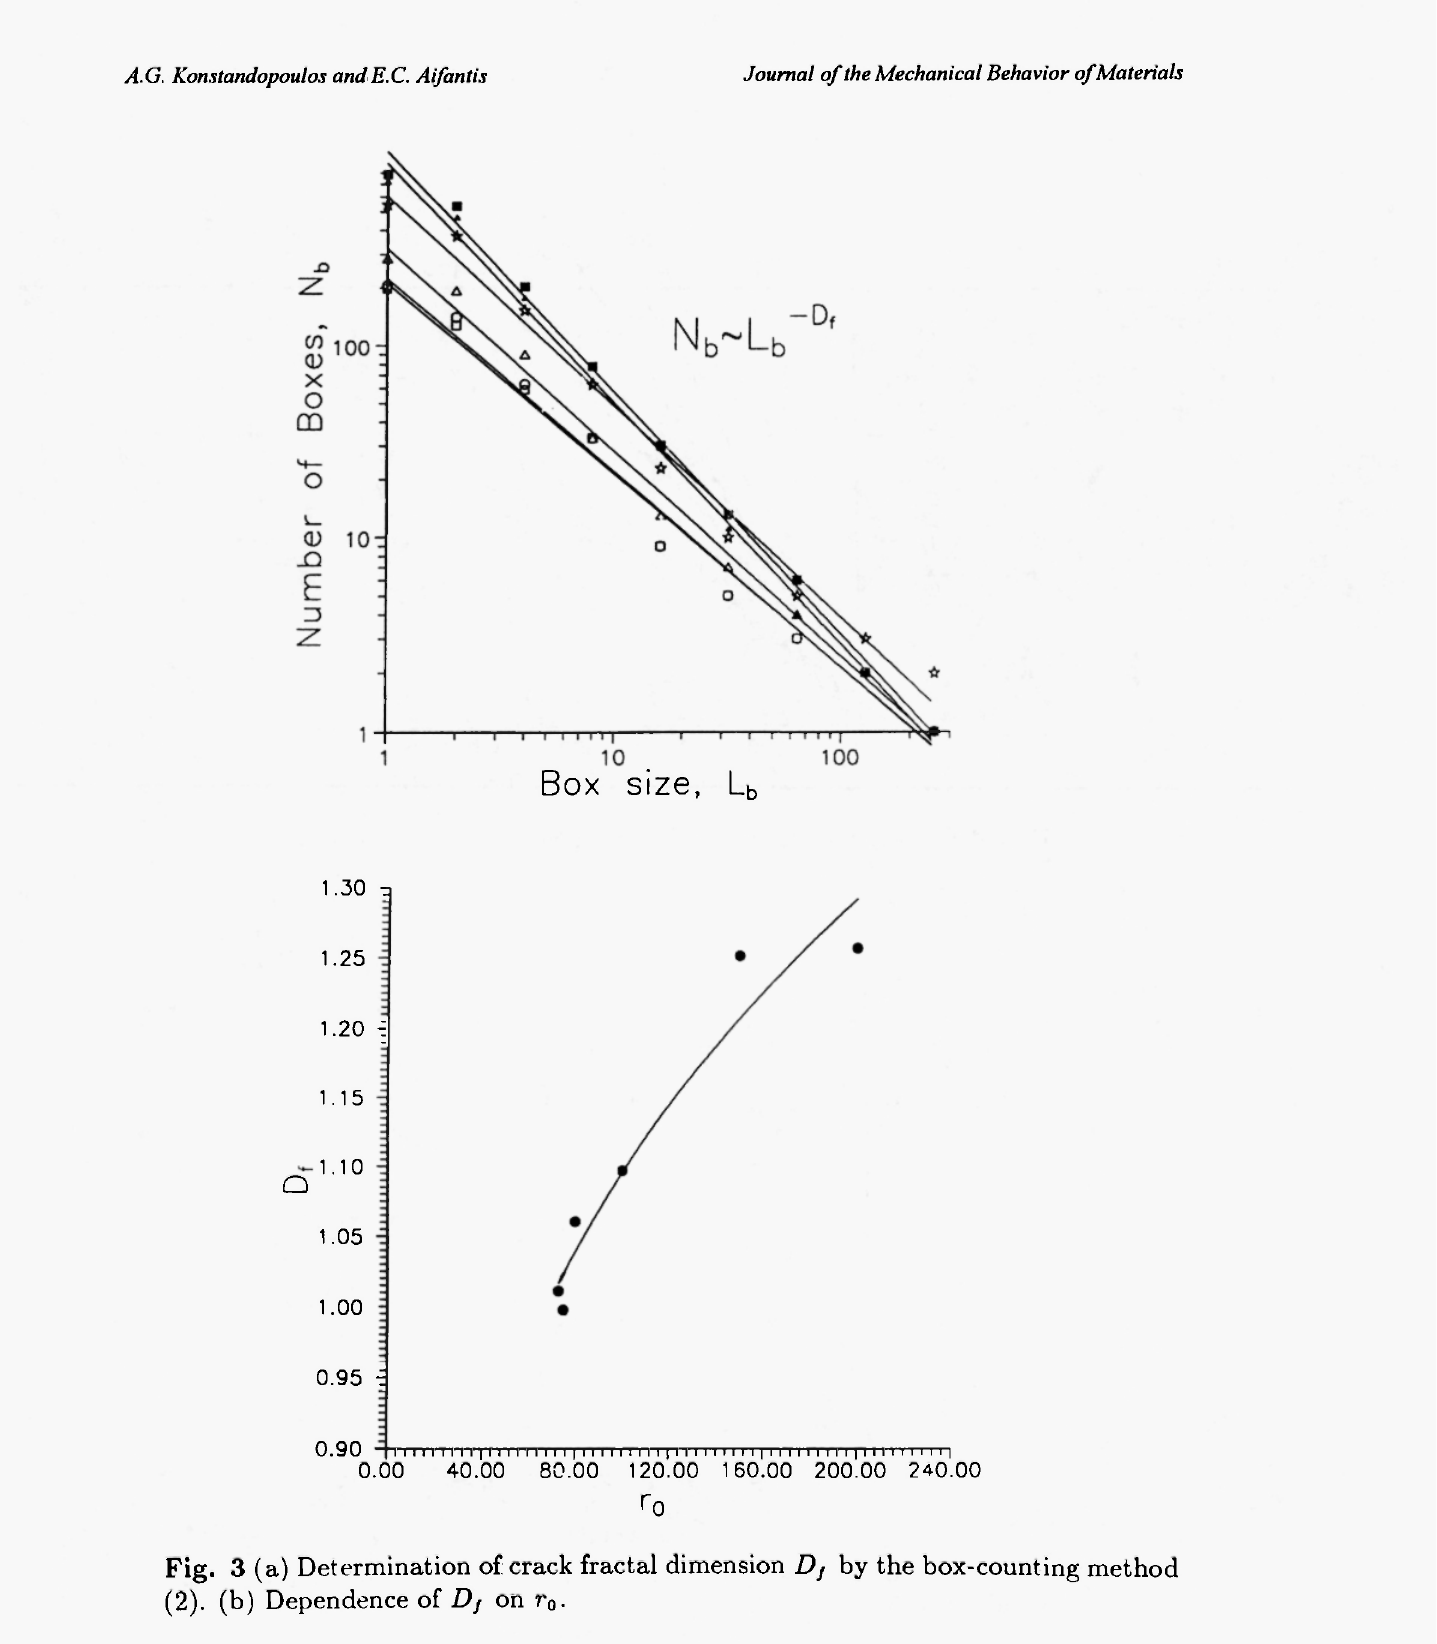
Fig. 3 (a) Determination of crack fractal dimension Dj by the box-counting method (2). (b) Dependence of Dj on r 0